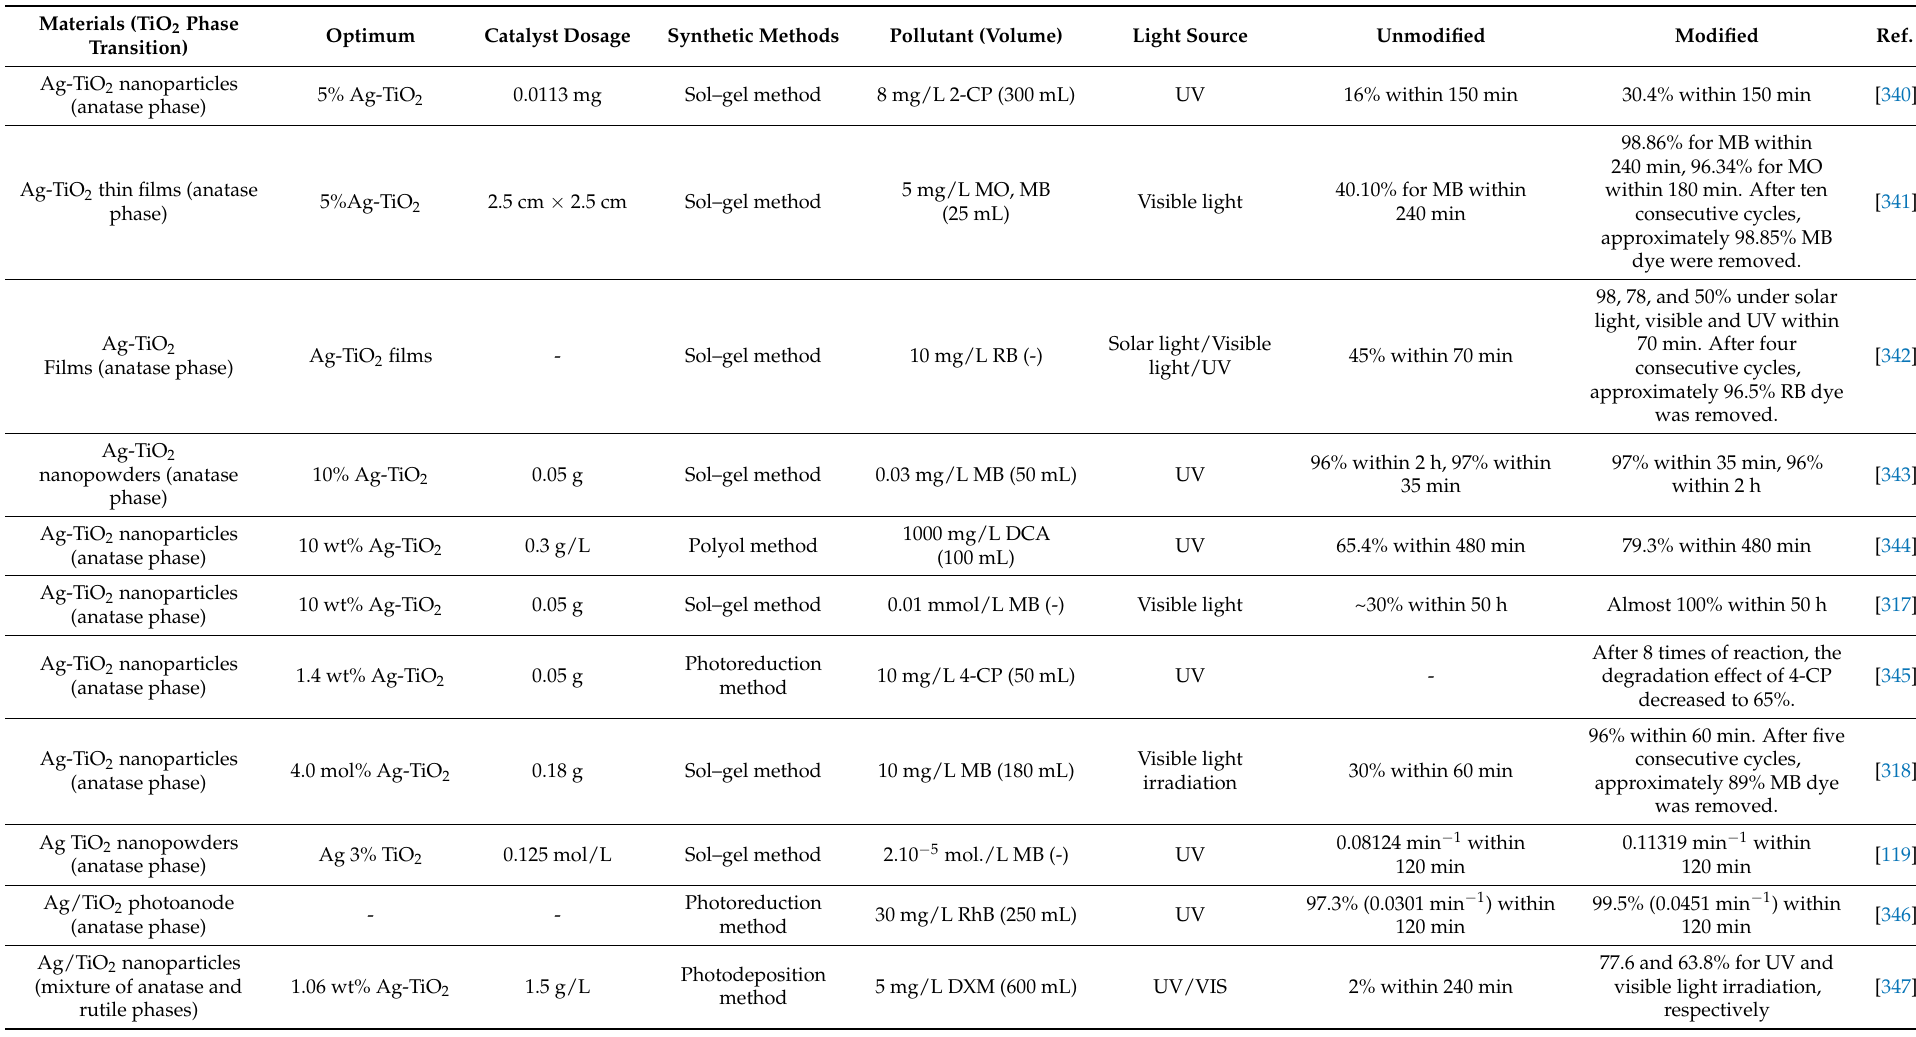
Table 16. Summary of recent progress on Ag-TiO 2 photocatalysts for organic pollutants